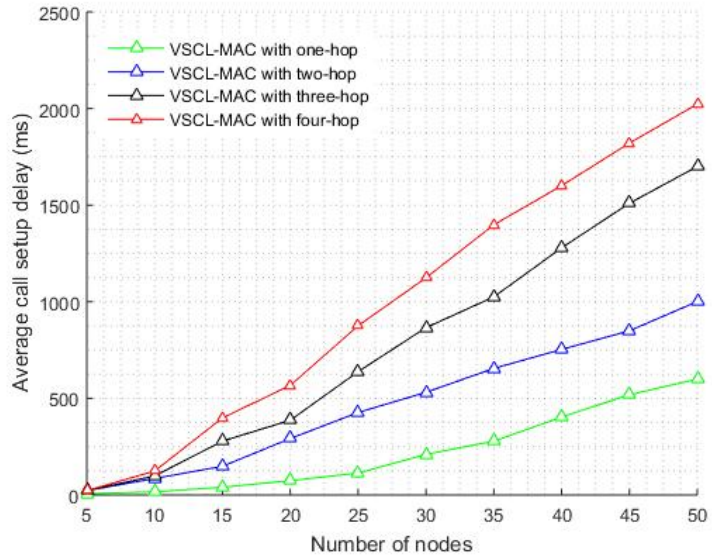
Figure 19. Average call setup time with respect to number of hops in VSCL-MAC